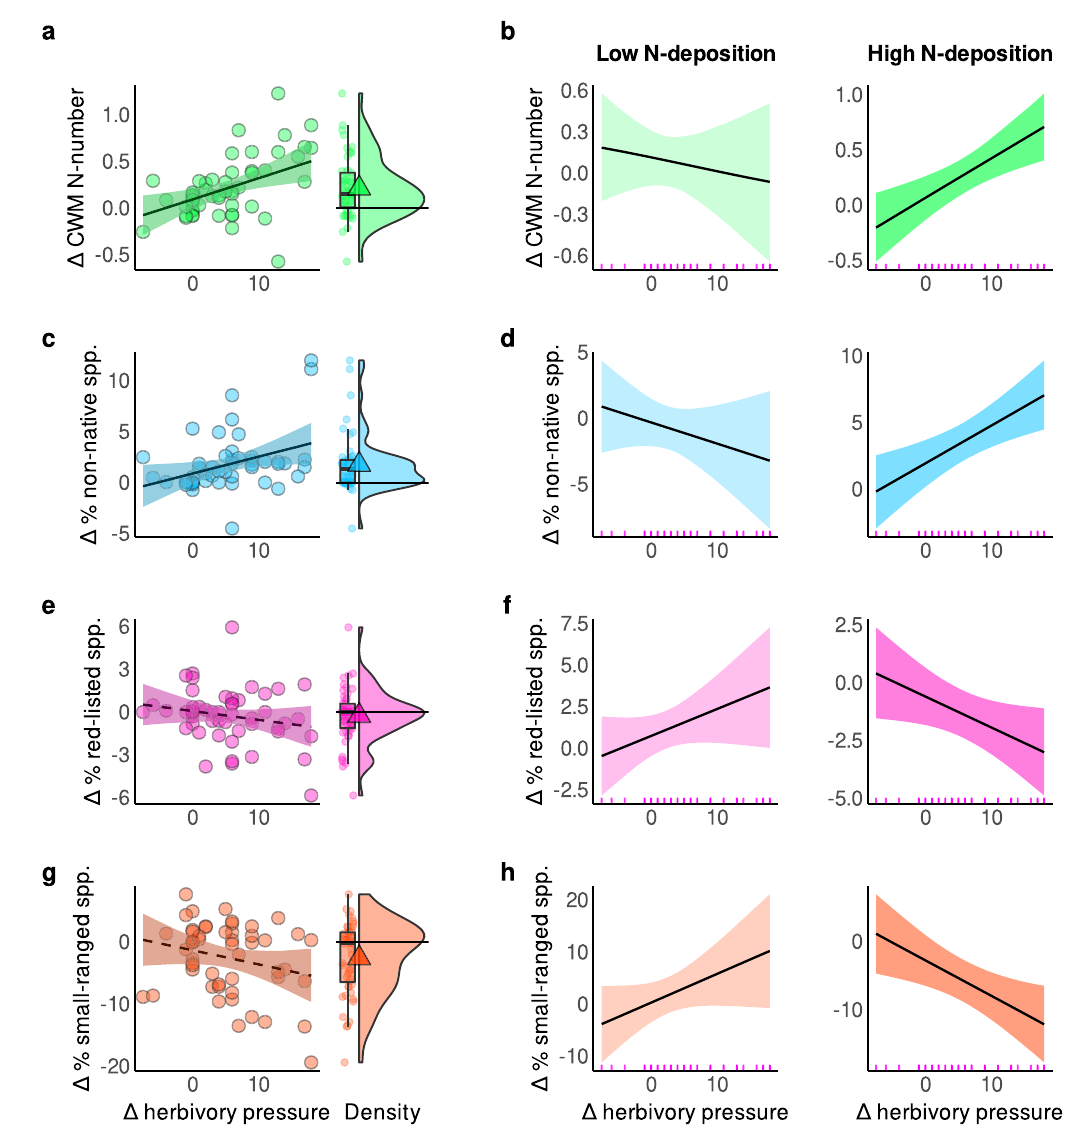
Fig. 4 | Herbivory effects depend on N-deposition levels. Relationships between change in ( Δ ) herbivory pressure and a Δ community-weighted mean N-number (CWM-N), c percentagechangein( Δ %)non-nativespecies, e Δ %red-listedspecies, and g Δ % small-ranged species. Frequency distributions (density, boxplot and points) of the respective response variables are displayed alongside. Boxplots boundtheinterquartilerange(IQR)dividedbythemedianandwhiskersextendup toamaximumof1.5×IQRbeyondthebox.Trianglesindicatethemean.Horizontal linesatzeroindicatenochange.HerbivoryeffectsdependonN-deposition( b,d,f , h ). Conditional effects of herbivory are depicted at the 10th (348kg/ha; left) and